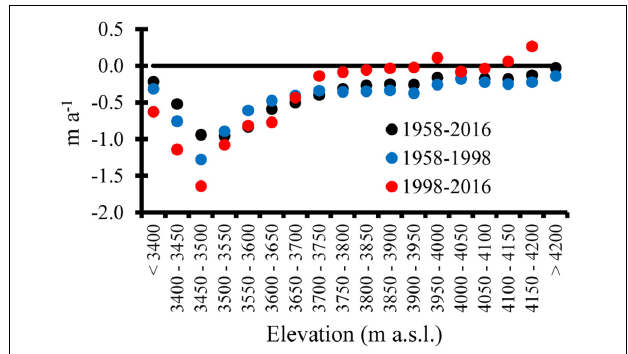
FIGURE 5 | Annual rates of glacier surface elevation change (m a − 1 ) for the Central Tuyuksu as a function of elevation in three assessment periods.